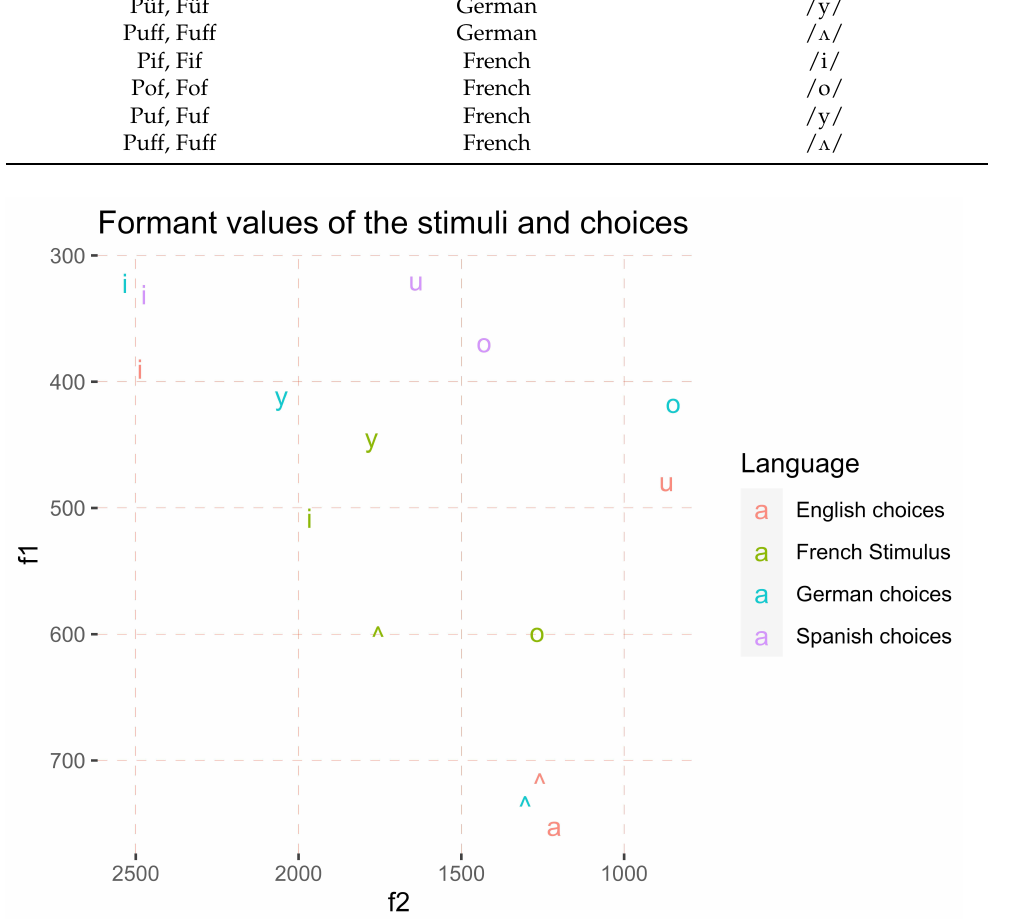
Figure 5. Formant values of the German and French stimuli relative to Spanish and English